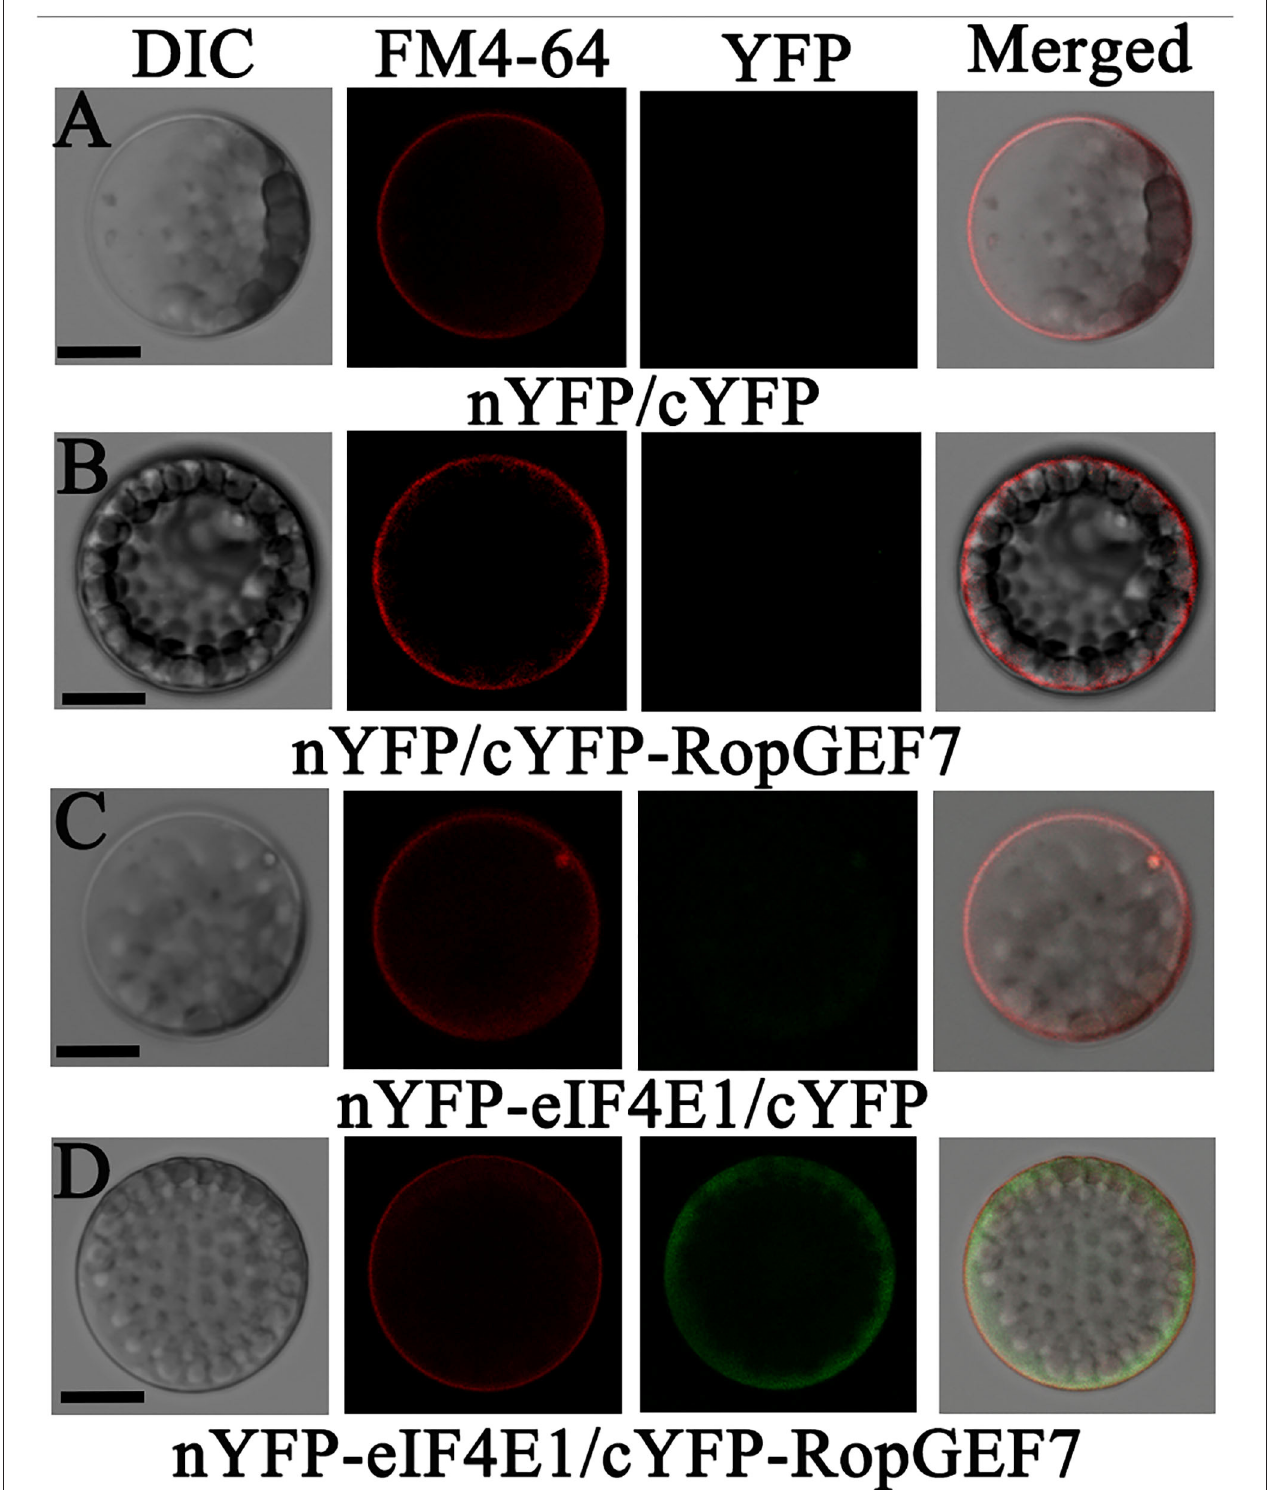
FIGURE 7 | eIF4E1 interacts with RopGEF7 in Arabidopsis protoplasts. (A–D) Arabidopsis protoplasts were co-transfected with (A) N-terminal YFP and C-terminal YFP , (B) nYFP and cYFP-RopGEF7 , (C) nYFP-eIF4E1 and cYFP , and (D) nYFP-eIF4E1 and cYFP-RopGEF7 . The FM4-64 dye labels the plasma membrane. Scale bars: 20 µ